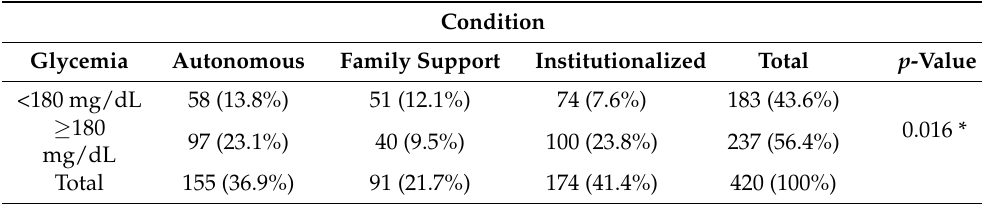
Table 2. Relationship between patient’s condition, gender, and age with glycemia levels.